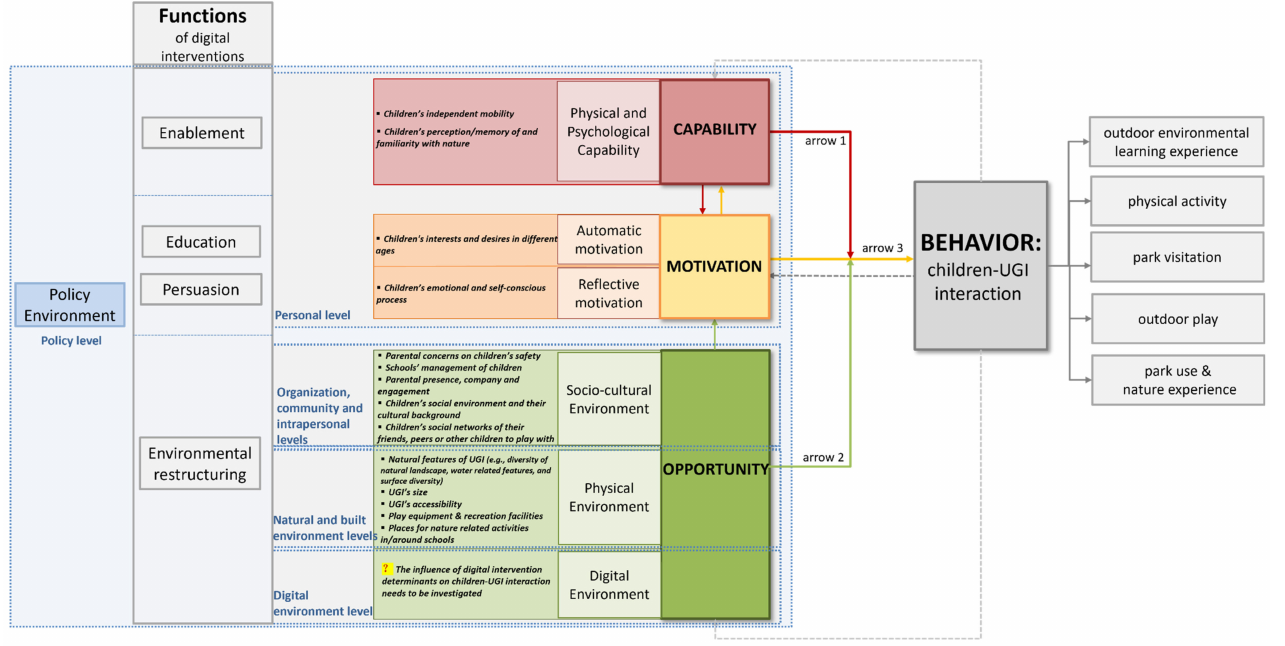
Figure 3. The conceptual model of the determinants of children–UGI interaction and the potential functions of digital